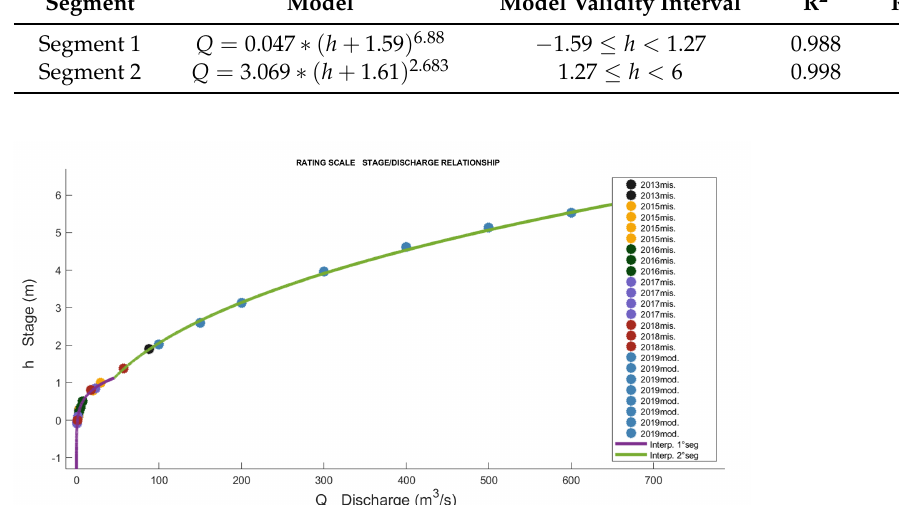
Figure 19. Rating scale of the Esino River with two